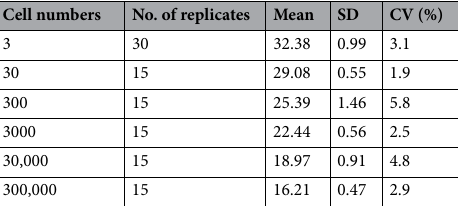
Figure 2. Optimization and Validation of Revised LTR-based qPCR and RTqPCR Assay Formats. ( a ) Optimization of the initial 496F/546P/633R primer–probe set for total HIV-1 DNA detection using universal cycling with tRNA; step-up cycling with no tRNA or step-up cycling with 10 ng/ml tRNA. Geometric means and standard errors of means are plotted for 3–12 replicates per sample. ( b ) Evaluation of the linearity of the RT-qPCR format of the 525F/574P/599R revised assay for detection of HIV-1 RNA on an AcroMetrix HIV-1 RNA Linearity Panel. ( c ) Demonstration of the linearity of the qPCR format of the revised HIV-1 laboratory developed assay on dilutions of crude lysates of 8E5 cells. ( d ) Plasma viral load limit of detection (LOD) determination of the RTqPCR format of the revised laboratory developed assay by probit regression of serial dilutions of EDTA plasma spiked with an HIV-1 AcroMetrix quantification standard near the cut-off level of the assay. The percentage of specimens detected at each copy level is indicated, and the 50% and 95% detection level extrapolated from the curve. Three replicates were used for 100 copies/ml while 10 replicates were used for the other dilutions. ( e ) Correlation in RNA plasma viral load measurements obtained by the revised laboratory developed assay and the Roche Cobas AmpliPrep/Cobas TaqMan HIV-1 test v2.0 assay. The analysis was performed on 127 high-titer HIV-1 spiked plasmas from the External Quality Assurance